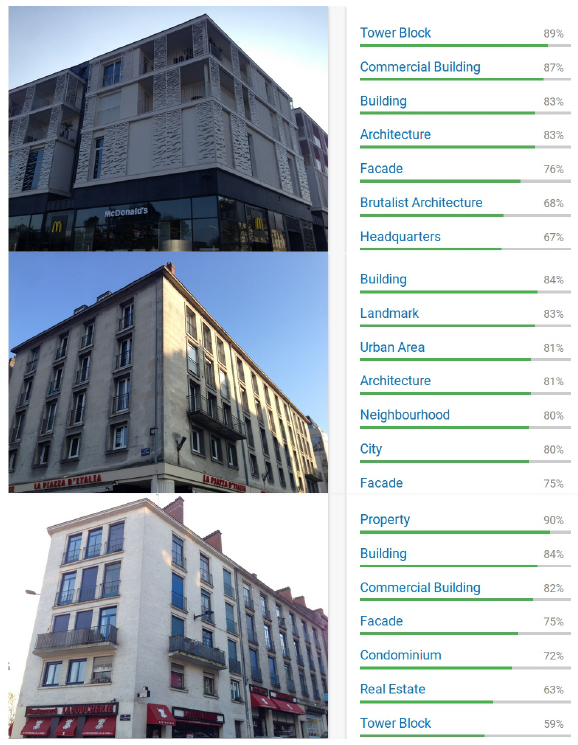
Figure 10. Image type detection samples (Our images).